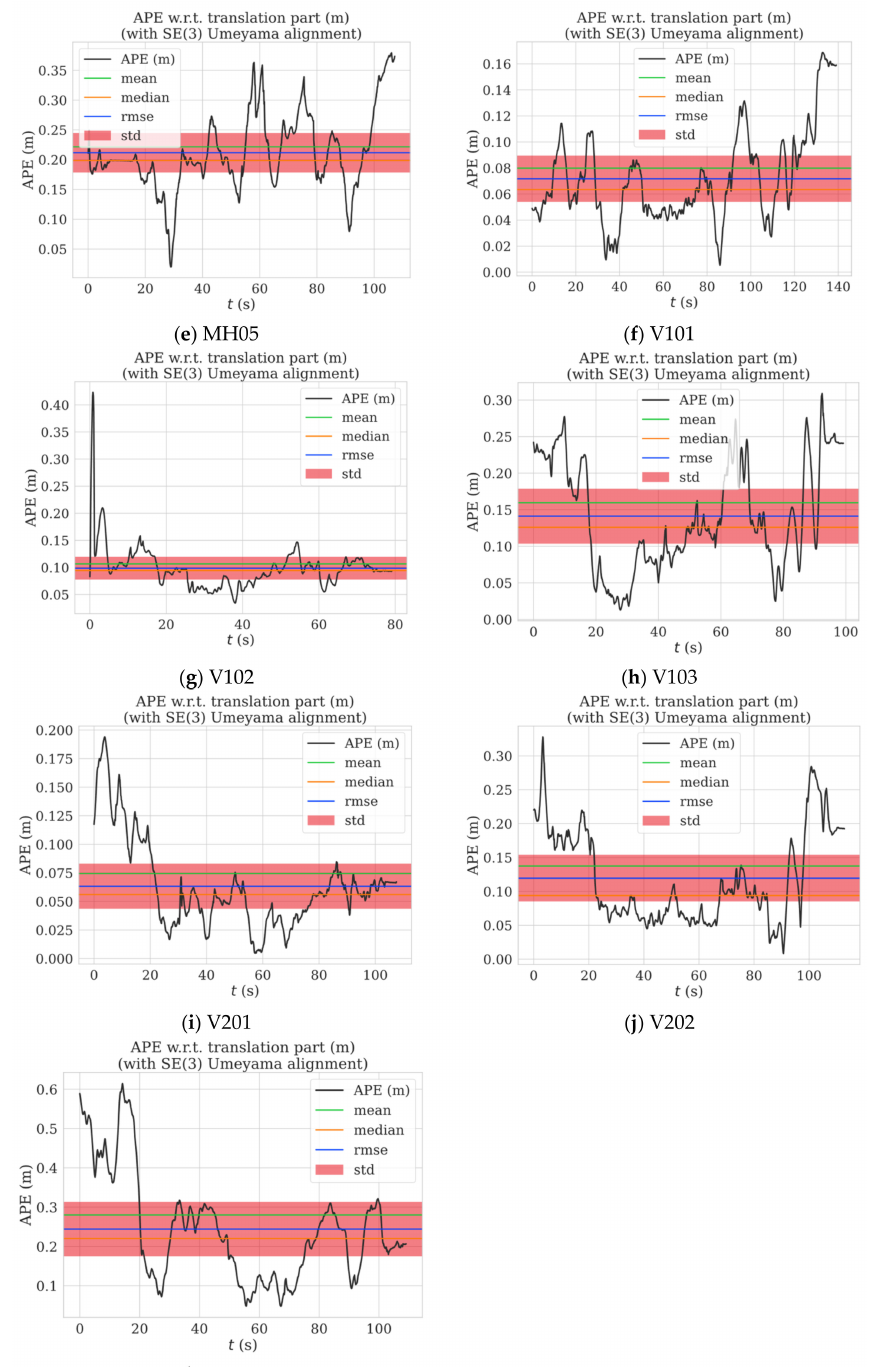
Figure 10. Pose error across the EuRoc